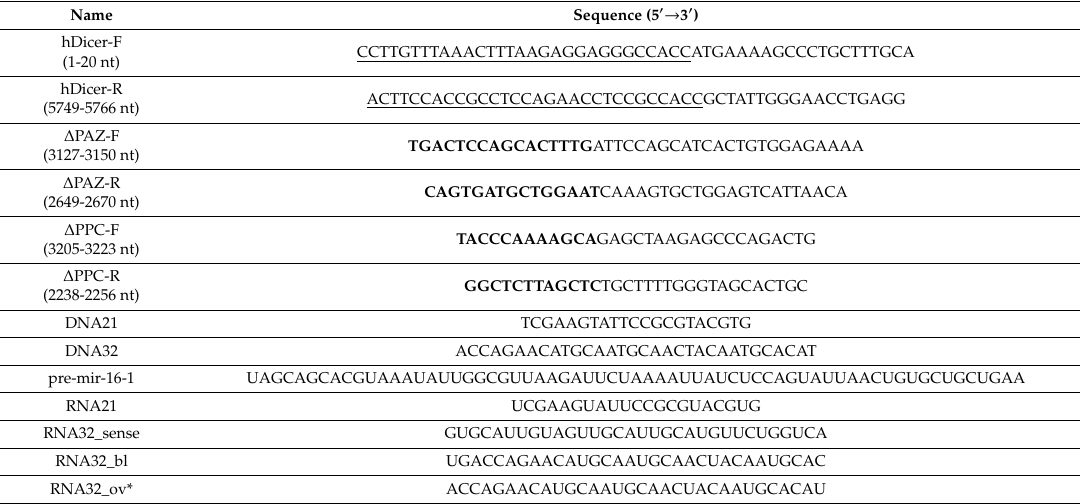
Table 1. Oligonucleotide